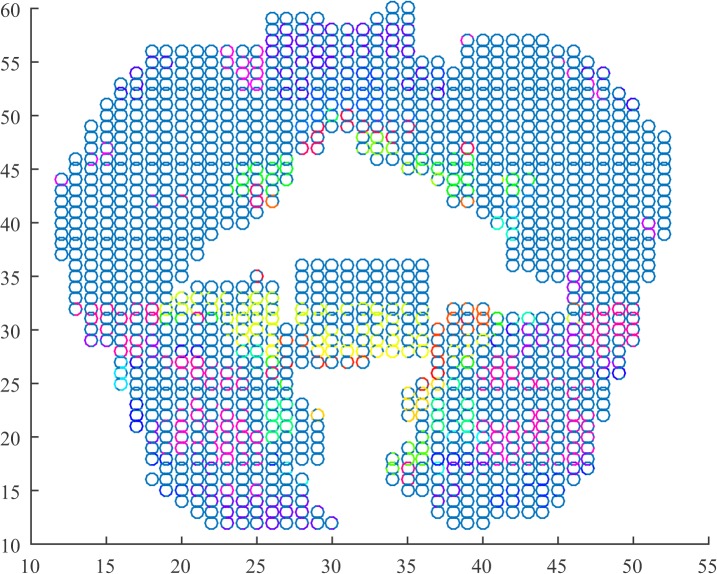
Cluster depiction in the coronal view (z = 0) of the cortex during question.Clusters identified by the regularity partitioning algorithm as seen on the coronal view obtained by the examined fMRI data. Each cluster is colored with a different color. During this epoch, the subject was exposed to a question. The stimulus was a sentence regarding an arrangement of symbols that would show up in the screen during the third epoch.